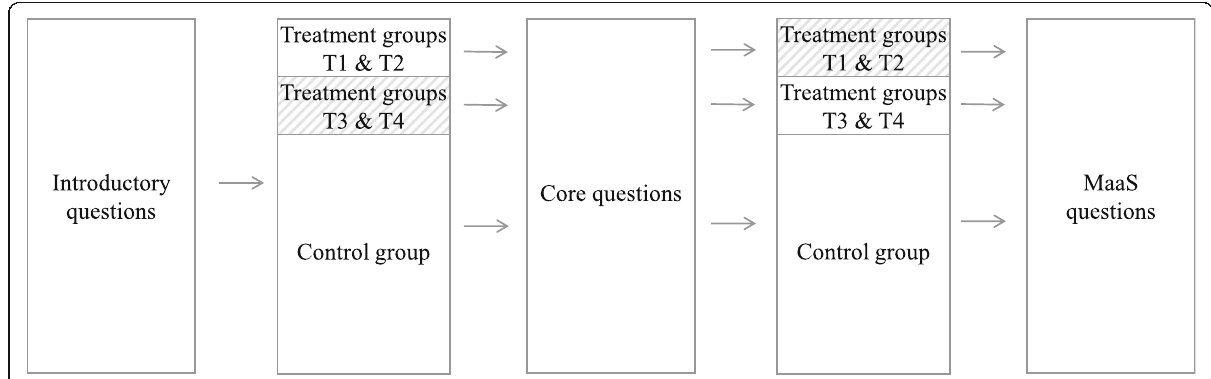
Fig. 1 Experimental setup. The treatment blocks with diagonal shading represent the time point of applying the